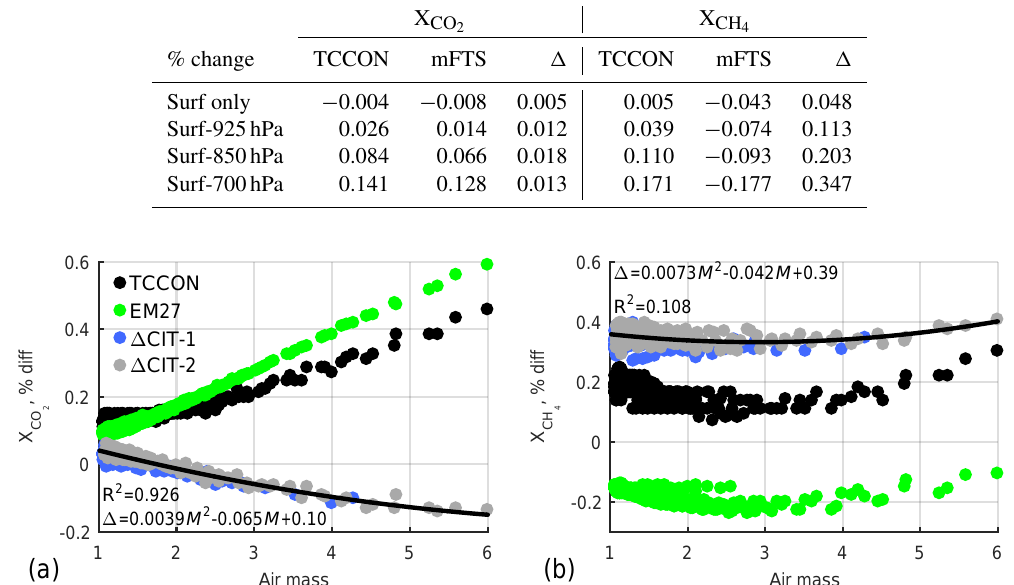
Figure 2. Sensitivity of TCCON- and mFTS-retrieved X CO 700hPa) a priori temperature. Green and black points are raw sensitivities, and blue and grey points are their differences during the two times at Caltech. Points are 10min averages, n = 397. For X CO X CH the TCCON–EM27 differences are larger (0.3–0.4%) but with little air mass dependence. The strong air mass dependence for X CO 4 suggests that air mass needs to be taken into account for X CO